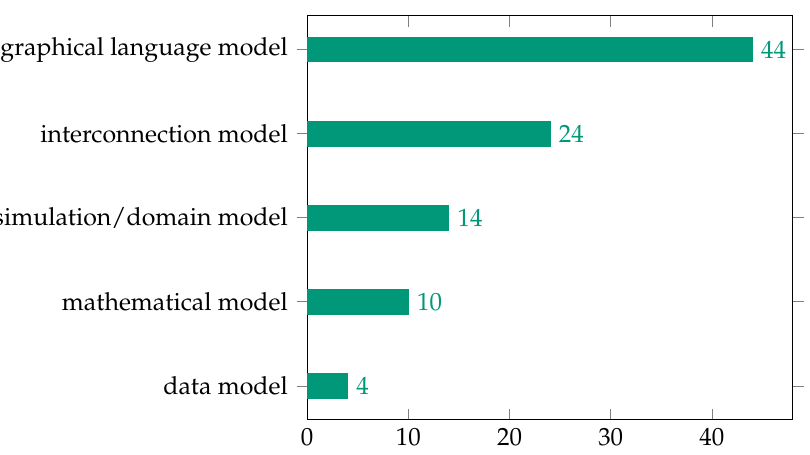
Figure 8. Number of definitions used in literature body (multiple assignments possible).